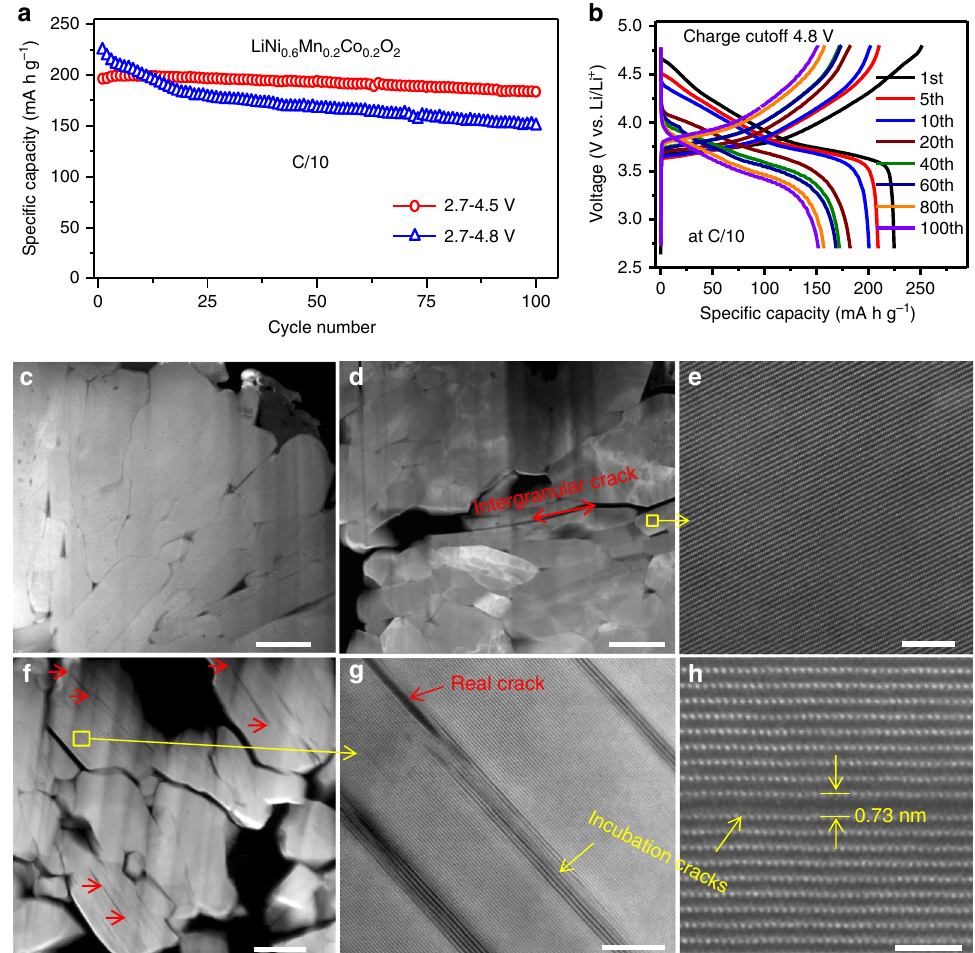
Fig. 1 Cycling performance and cracks of LiNi 0.6 Mn 0.2 Co 0.2 O 2 . a Capacity decay and b corresponding charge – discharge voltage pro fi le evolution at cycling window 2.7 – 4.8 V. Cross-sectional high angle dark fi eld (HAADF) images from ( c ) pristine sample d , e after 100 cycles at 2.7 – 4.5 V, f – h after 100 cycles at 2.7 – 4.8 V. Red arrow in ( d ) highlights intergranular cracks formed during cycling. Red arrows in ( f , g ) highlight some intragranular cracks within primary particles. Yellow arrows in ( g , h ) highlight incubation cracks. The scale bars are 500 nm in ( c – f ), 10 nm in ( g ) and 2 nm in ( h